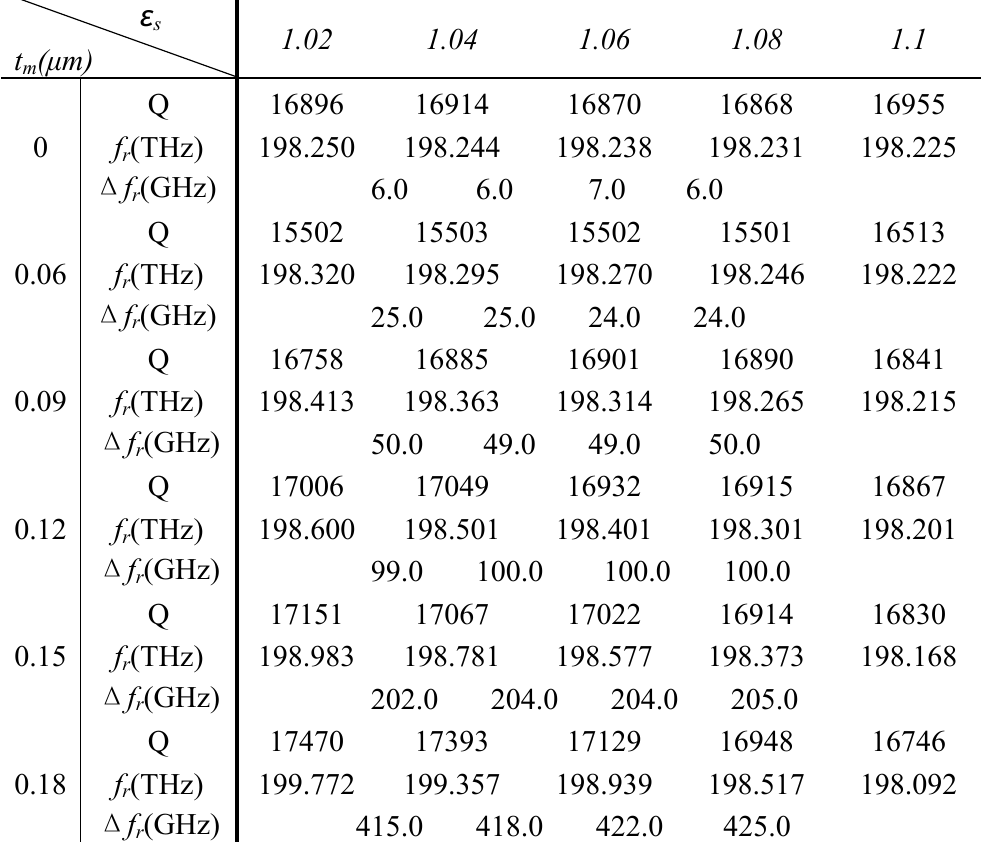
Table 4. Q factor, resonant frequency and frequency shift calculated from Figure